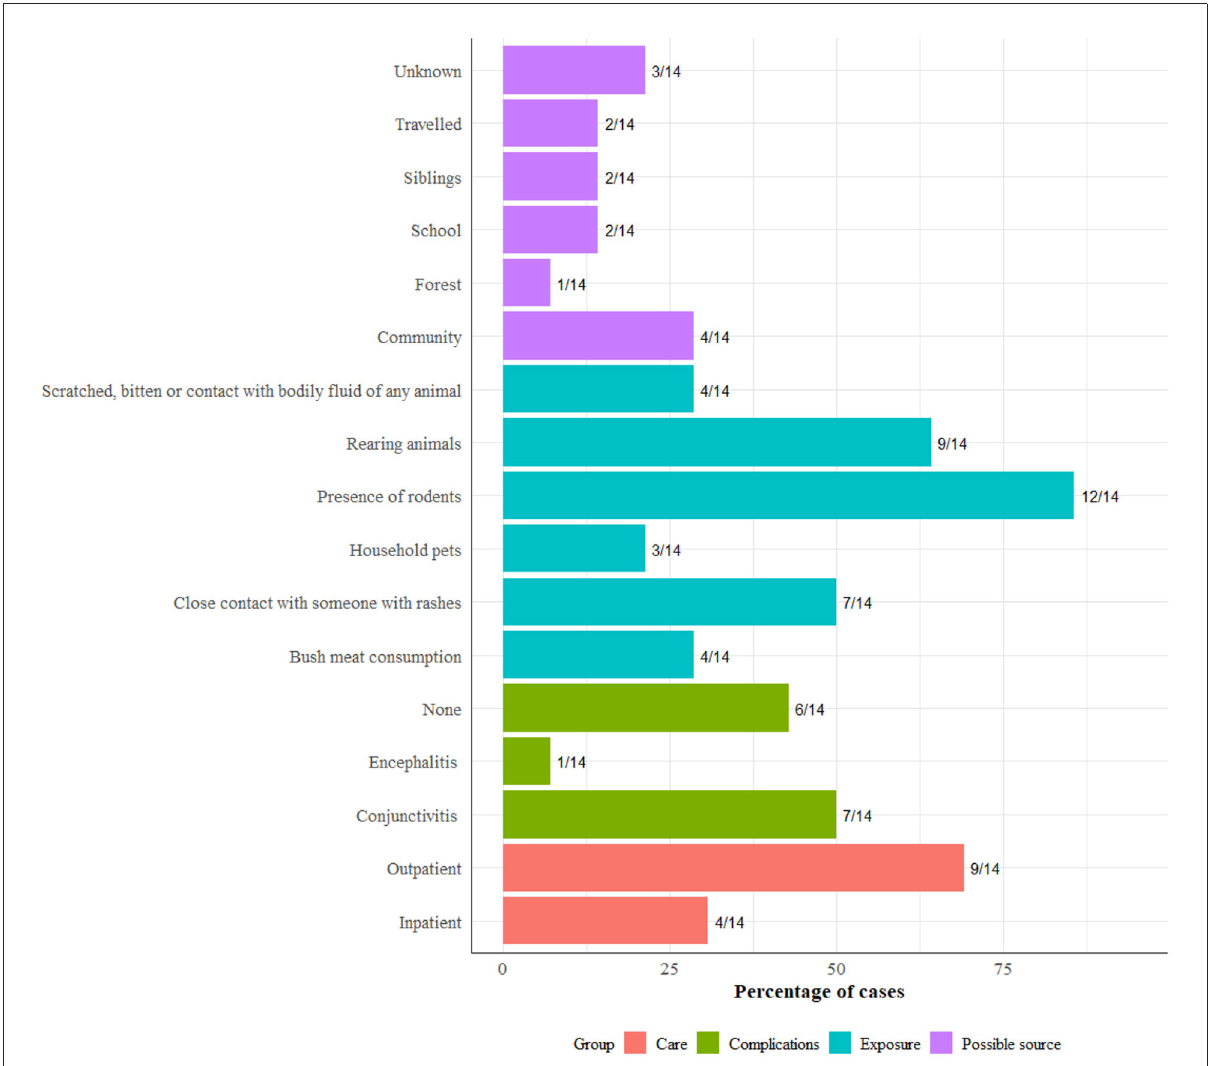
FIGURE7 Exposure, complication, care type, and comorbidities among 14 patients included in the follow-up